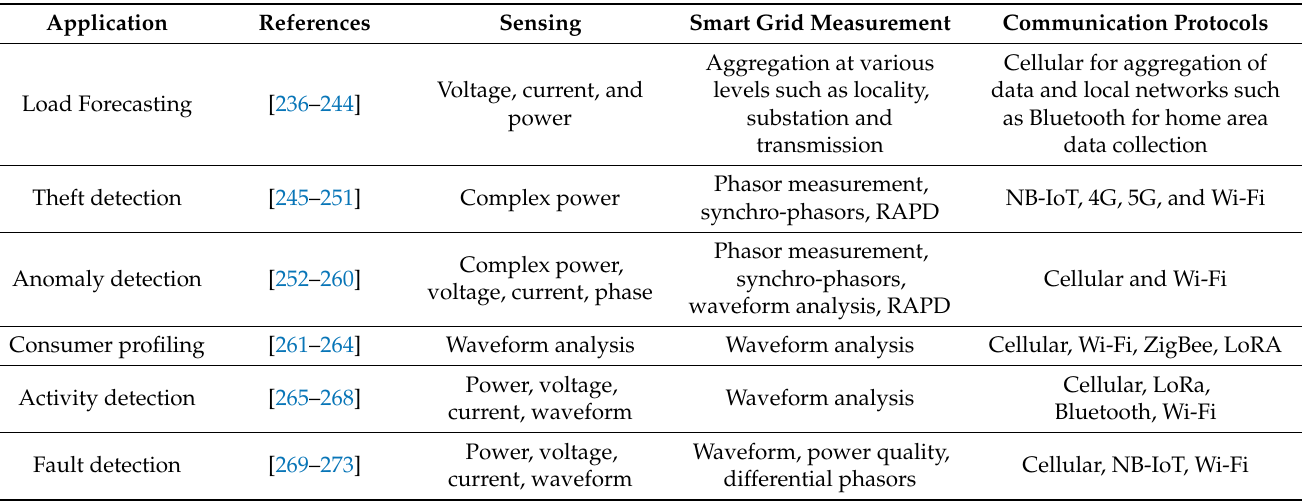
Figure 4. Usage cube for different IoT technologies for smart meters. Table 10. Applications of smart meter data with description of different component technologies